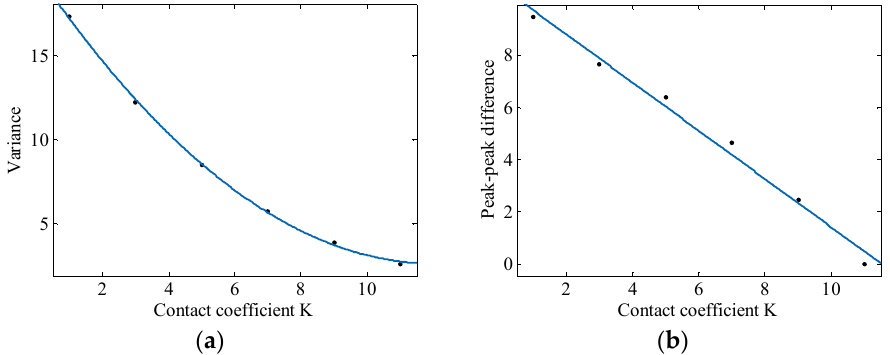
Figure 17. Relationship between characteristics of TPD and K : ( a ) variance, ( b ) peak-peak difference.